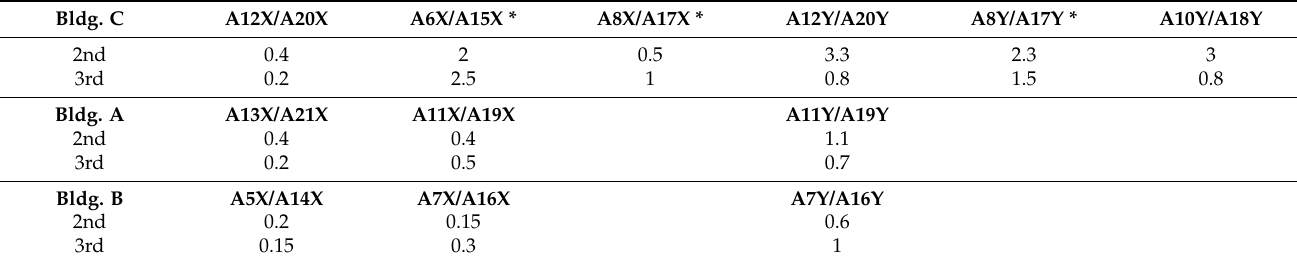
Table 5. Maximum inter-storey (2nd = inter-storey between levels 1 and 2; 3rd = inter-storey between levels 2 and 3) drifts (in %) recorded by the monitoring system. Sensor locations and level numbers are reported in Figure 4; sensor names are completed with the axis direction. For sensors located in collapsed portions, evidenced with an asterisk, the values before the collapse are listed.